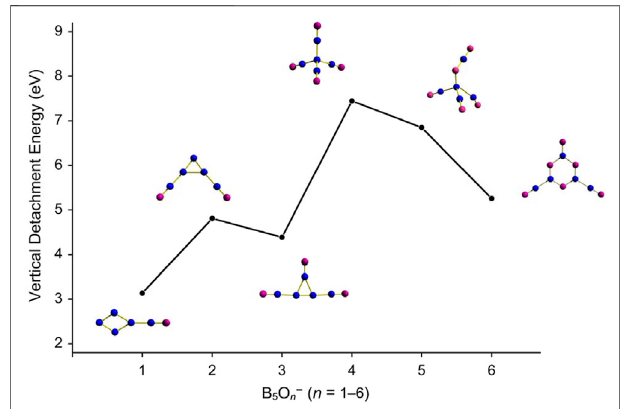
FIGURE 5 | Evolution of ground-state vertical detachment energies (VDEs) of B 5 O n − ( n = 1 – 6) series calculated at the PBE0/6-311+G(d) level.